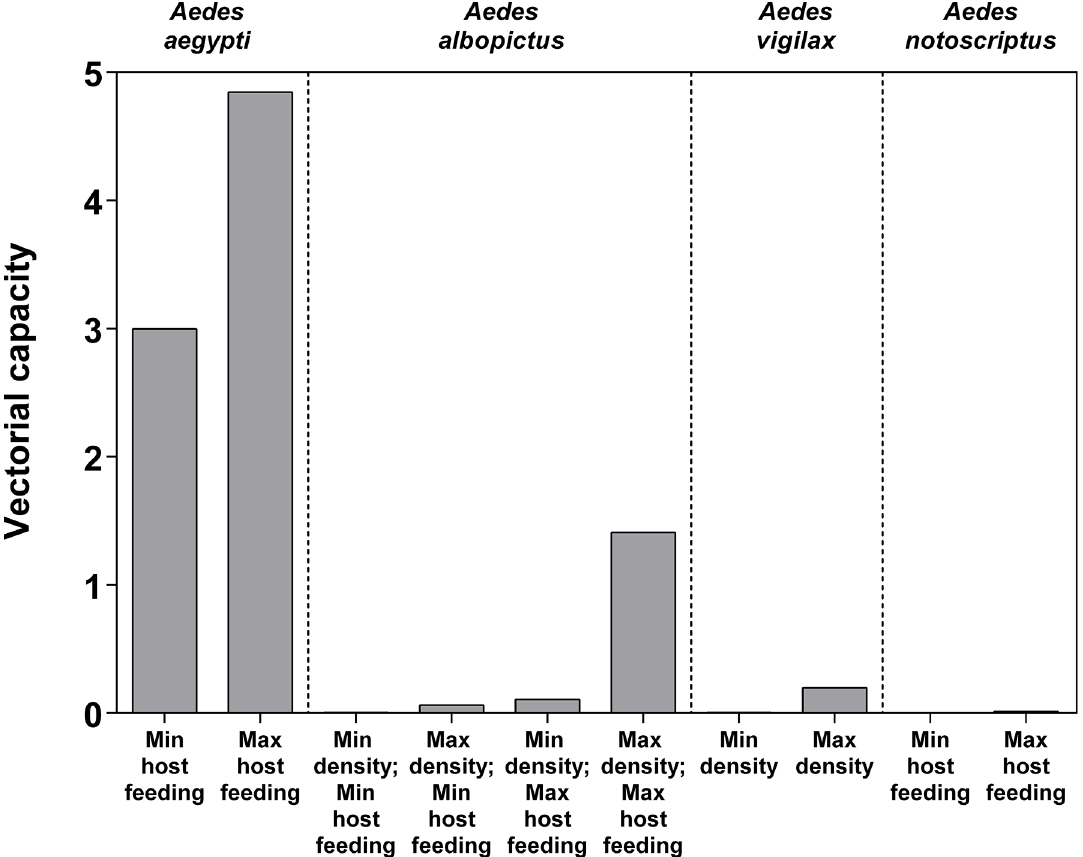
Fig 1. Comparison of vectorial capacity for four species, given maximum and minimum estimates of density and/or host feeding preferences where data available from the literature (refer Table 1).